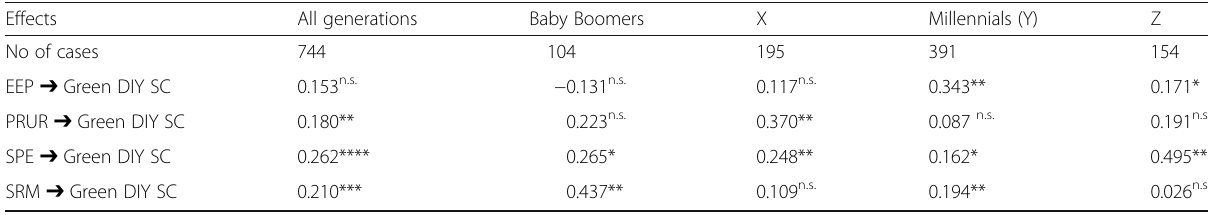
Table 4 Influences of DIY Store choice among consumer generations